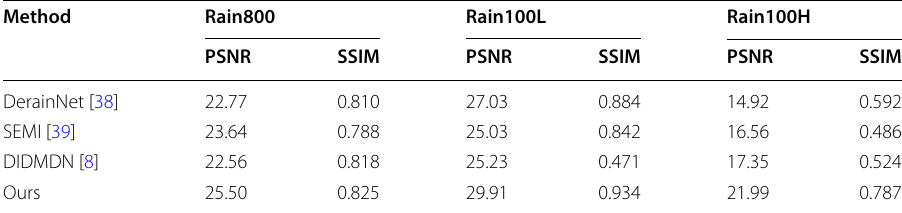
Table 4 De-raining performance comparison on the several datasets